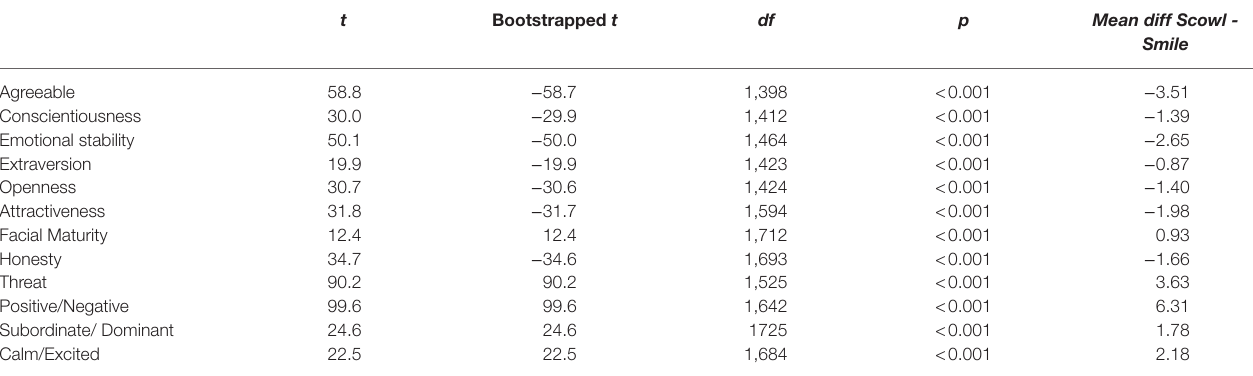
TABLE 4 | Yuen’s robust independent samples t -test, scowl and